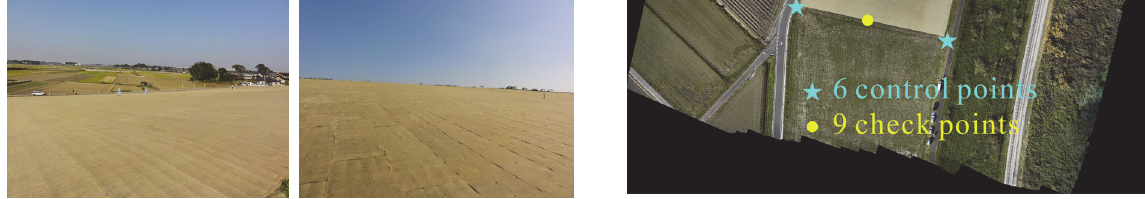
Figure 2. Test field as of November 7, 2016